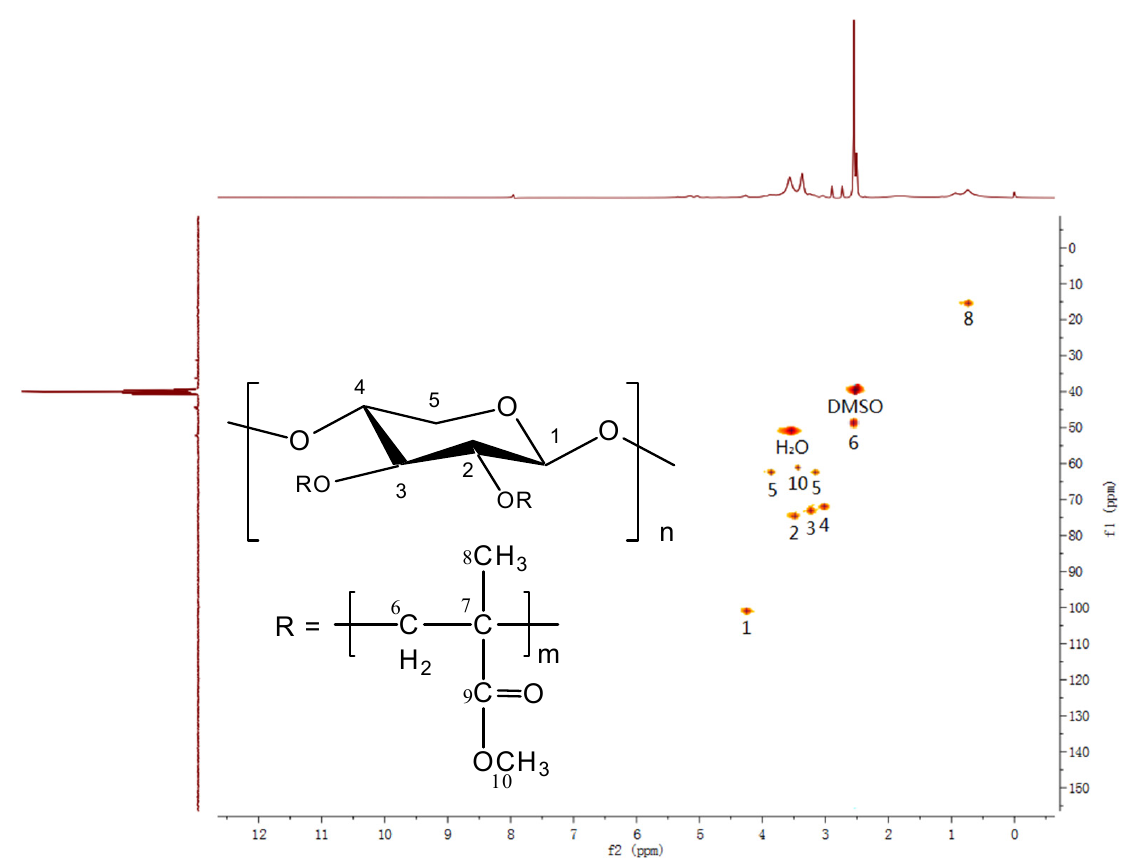
Figure 2. 1 H- 13 C HSQC NMR spectrum of xylan-g-PMMA.